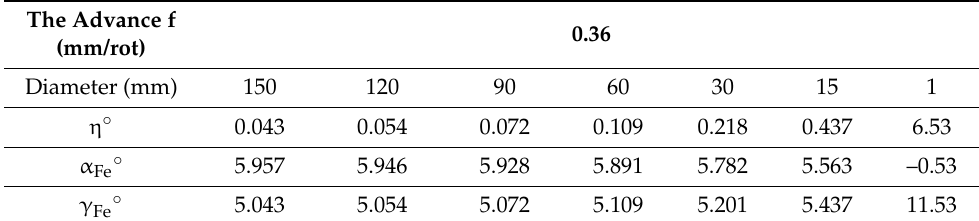
Table 3. The values of the angles η ◦ , α Fe ◦ , and γ Fe ◦ depending on the processed diameter ( D M ). The Advance